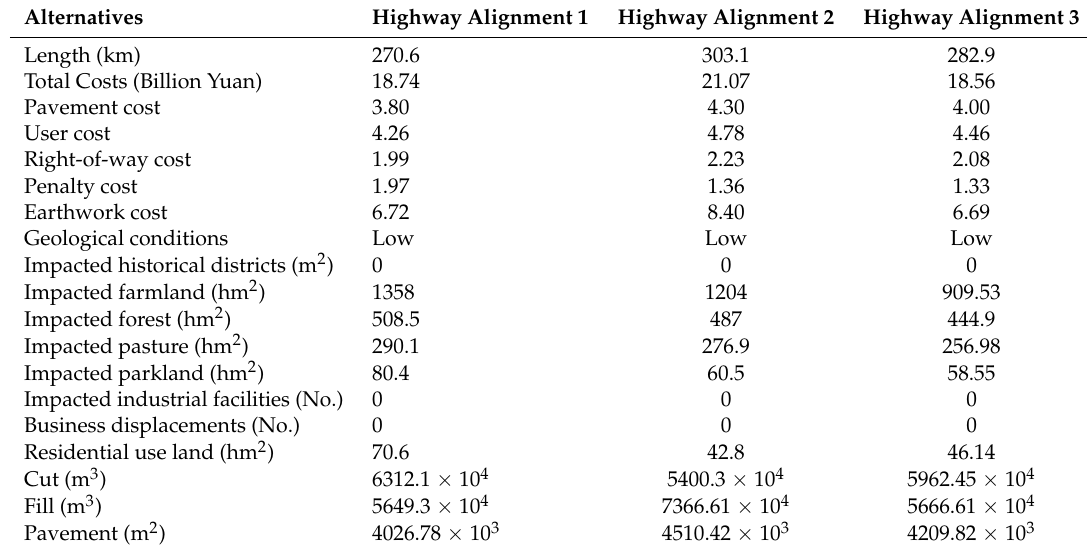
Table 1. The summary of cost and environmental impacts of the alignment